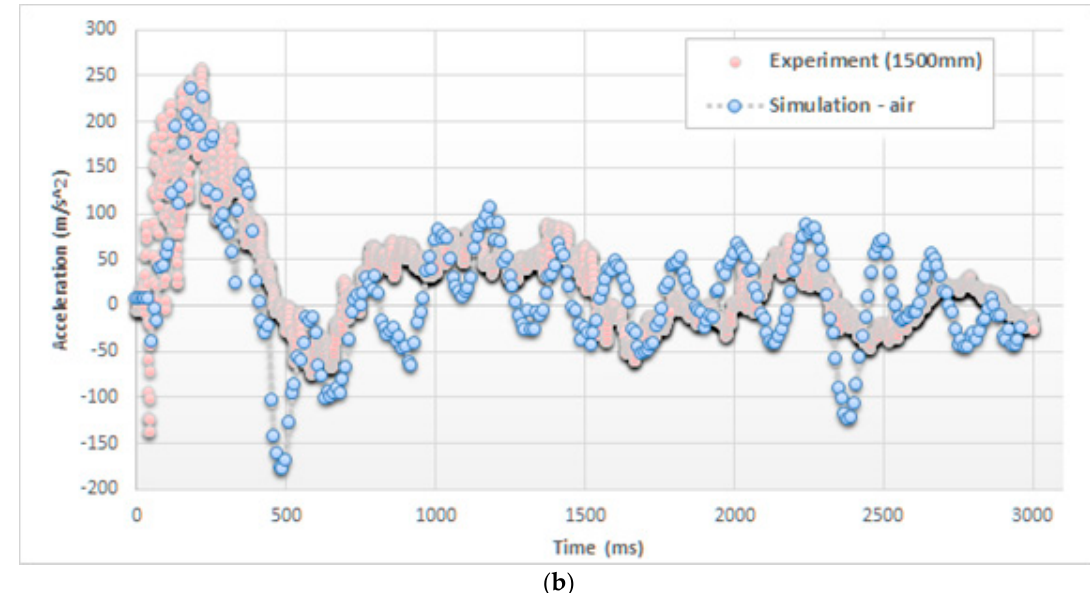
Figure 5. Comparison of acceleration on the top of the cylinder (drop height of 1500 mm), ( a ) without and ( b ) with considering the air effect.